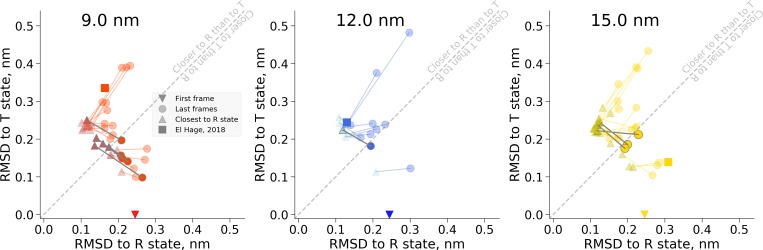
RMSD values for the snapshots of hemoglobin simulations in 9 nm (left), 12 nm (middle) and 15 nm (right) boxes.The simulations start from the T state and are marked by a down-pointing triangle symbol. The last frames of the trajectories are depicted as circles. The frames in every trajectory that approach the R state the closest are shown as up-pointing triangles. Connecting the frames that belong to the same trajectory (lines between triangles and circles) allows tracking the possible back transitions where hemoglobin approaches the R state and afterwards returns closer to the T state. These back transitions cross the diagonal line and are highlighted in darker gray.10.7554/eLife.44718.004Figure 1—figure supplement 1—source data 1.This figure is made from the same data as Figure 1.